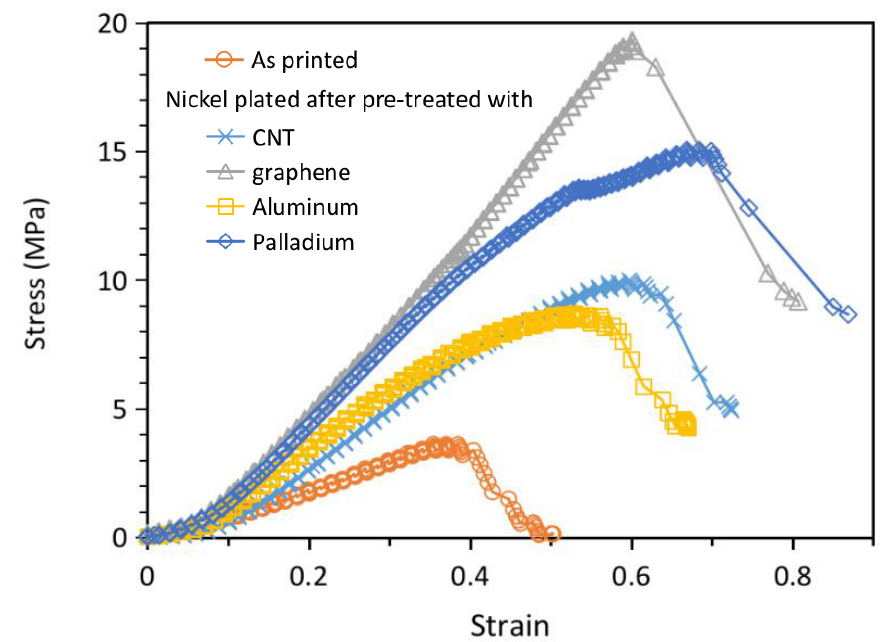
Figure 12. Compressive load-displacement relations to failure of the 130- µ m micro-lattice structures with different plating treatments. Table 6. Compressive failure load and displacement of the micro-lattice structures with unit cell length of 130 μm with different nickel -plating treatments.